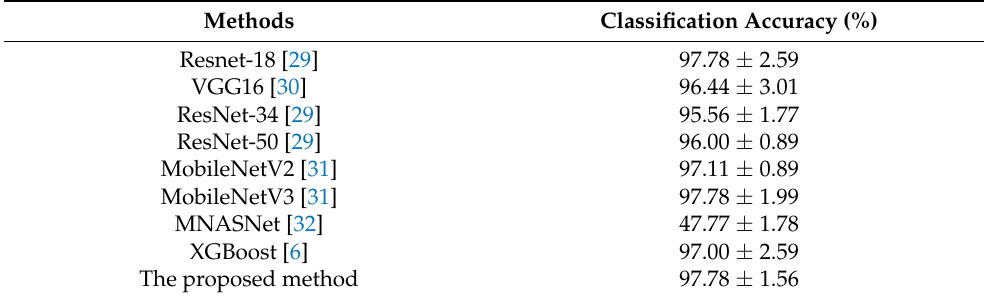
Table 5. Comparison of classification accuracy on the testing set for different methods, where the data are in the format of µ ± ∆ x , µ represents the mean value of the results, and ∆ x shows the confidence interval with a confidence limit of